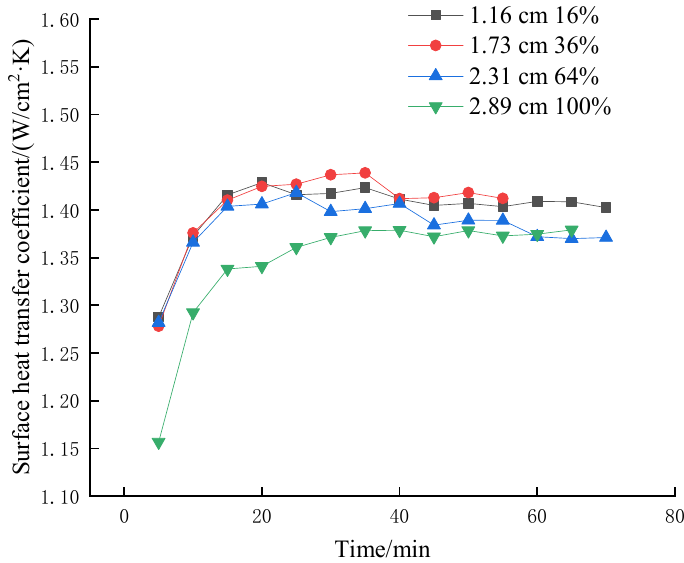
Figure 14. The influence of the coverage rate of changing height at 50 W/cm 2 on the transient surface heat transfer coefficient.